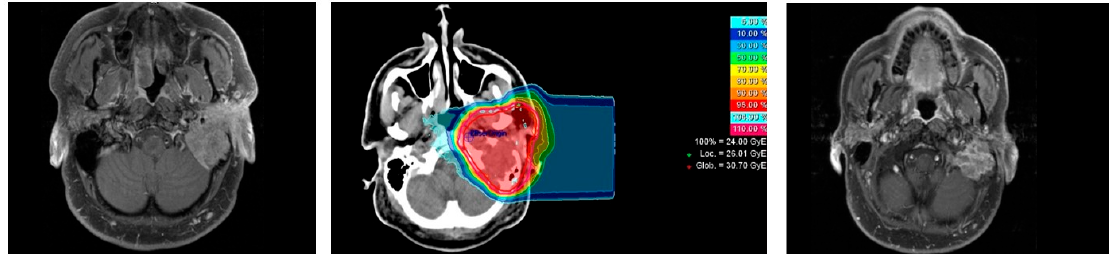
Figure 1. Example of patient with primary acinic cell carcinoma cT4 pN2a cM0; left panel: contrast-enhanced T1-weighted MRI at diagnosis; middle panel: carbon-ion radiotherapy boost plan; right panel: contrast-enhanced T1-weighted MRI at follow-up with in-field local recurrence.